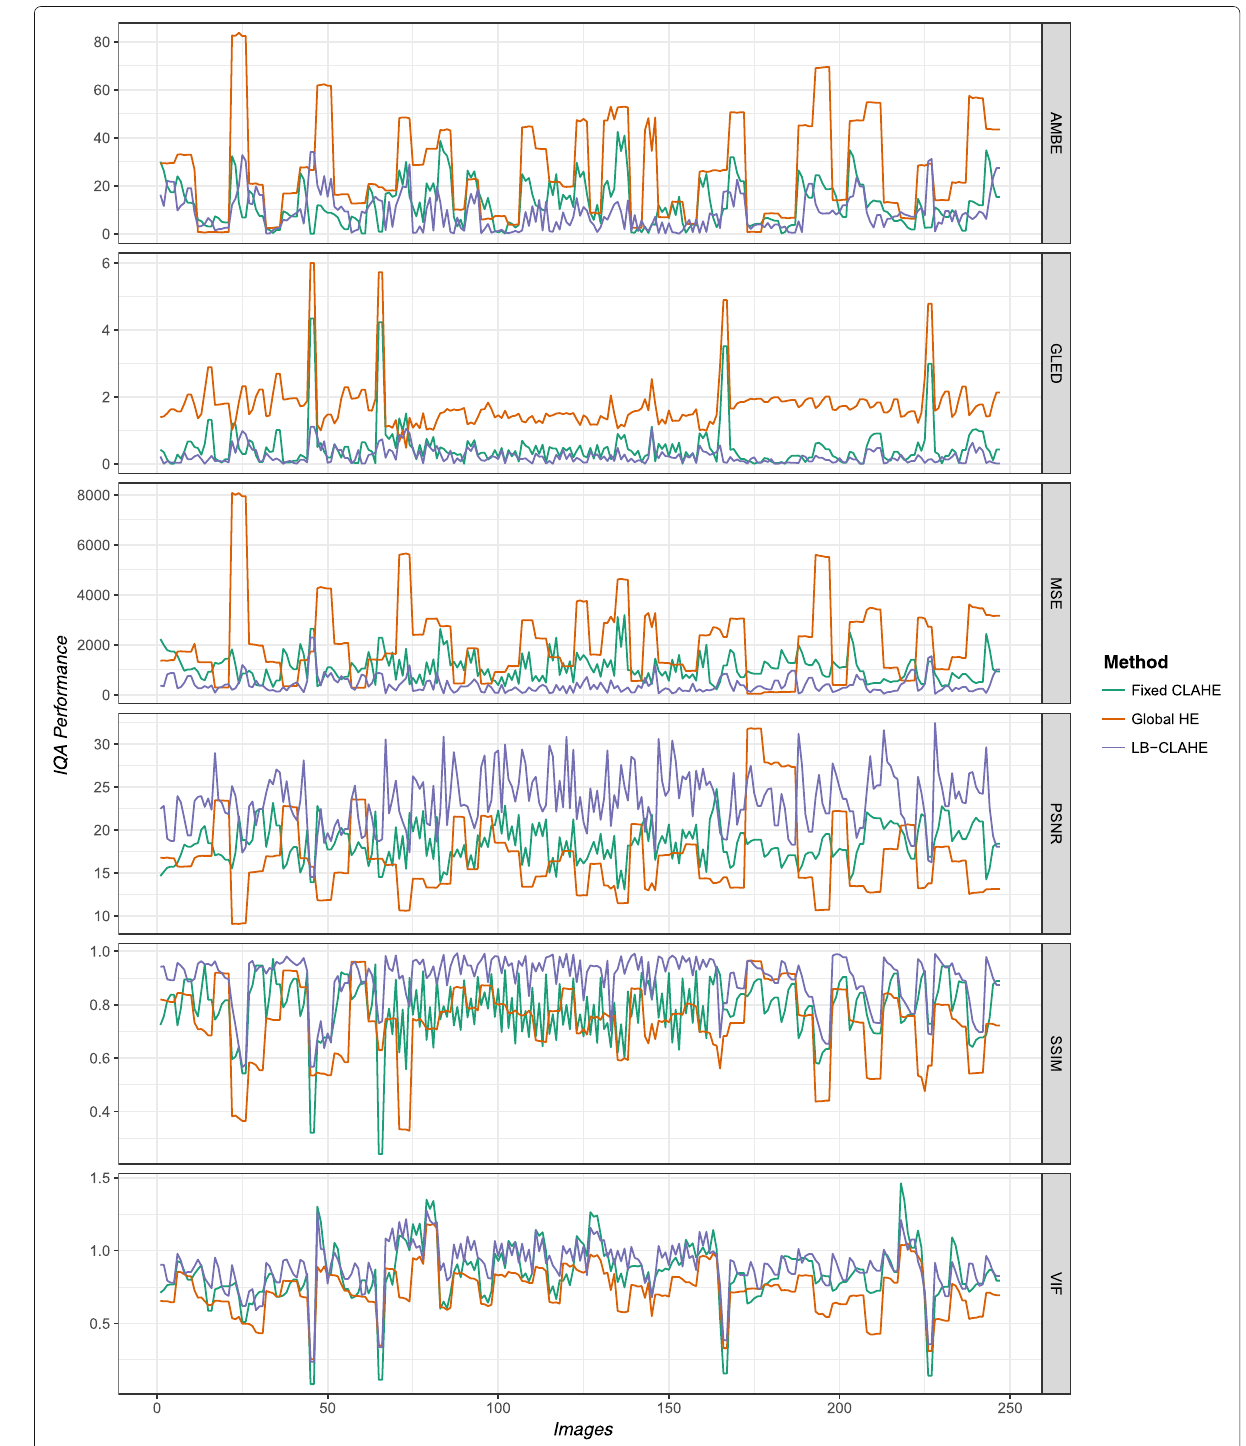
Fig. 8 Performance of LB-CLAHE and baselines regarding IQA techniques. Lower values are desired for GLED, MSE, and AMBE, while higher values are desired for PSNR, SSIM, and